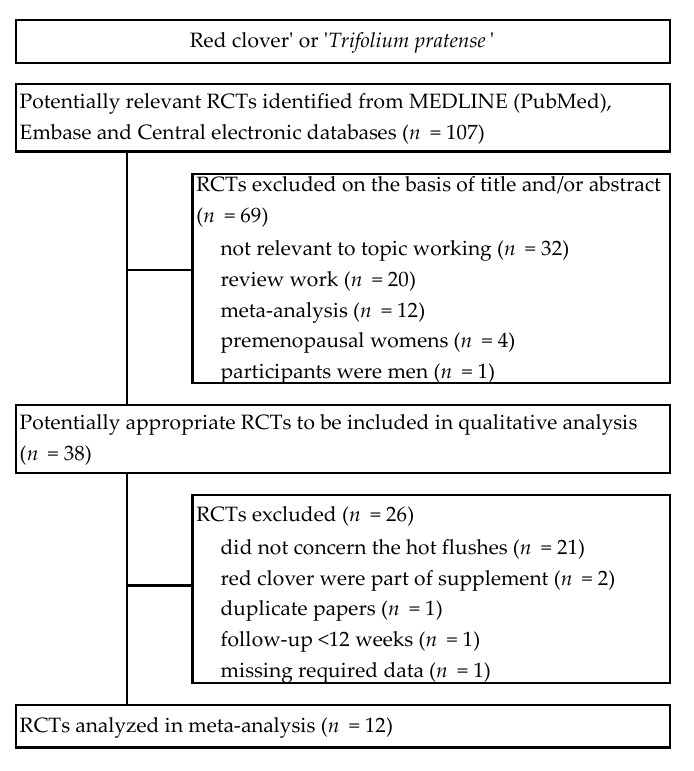
Figure 1. Flowchart of the selection procedure for studies included in the current review regarding red clover in menopausal symptoms. Abbreviations: RCTs, randomized controlled trials.